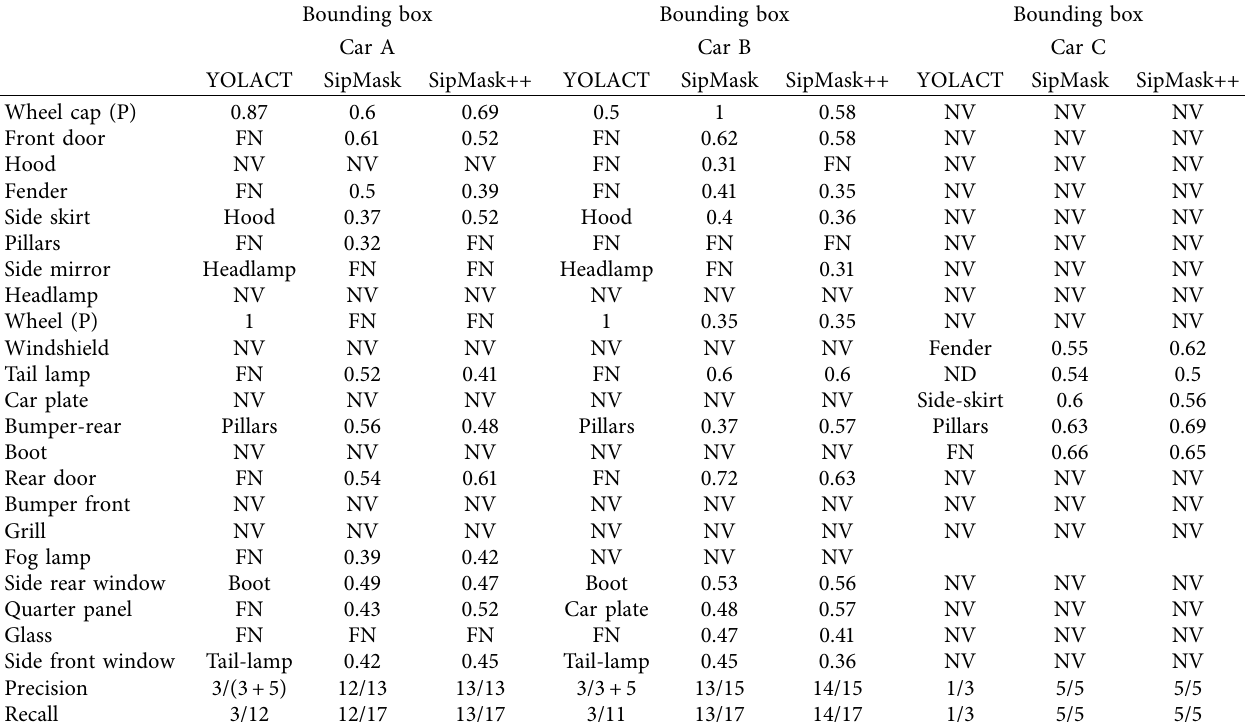
Table 5: A part-level bounding box analysis of Dataset-3 performance. Te numbers represent the score of one or more parts identifed correctly. NV means not visible. ND means not detected (false negative) and the remaining is the parts names.